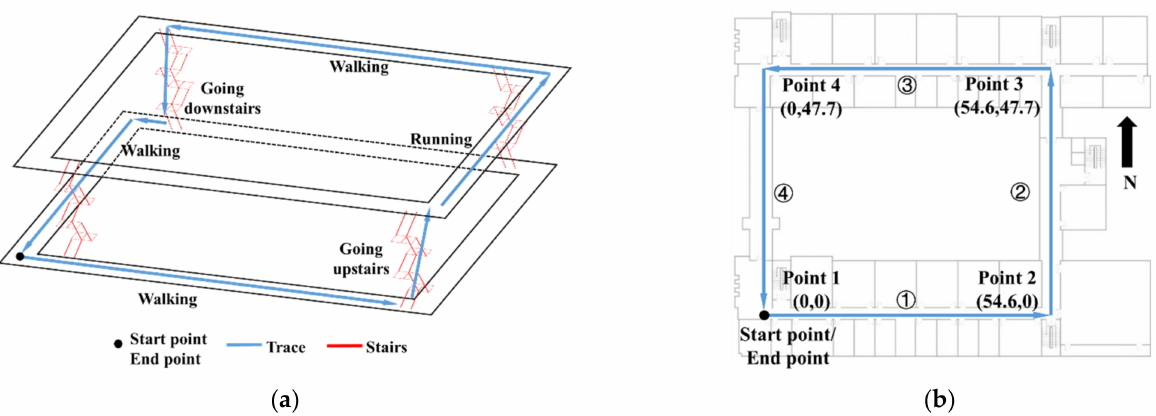
Figure 11. Trajectory of the experiment: ( a ) three-dimensional trajectory; and ( b ) two-dimensional trajectory projection.